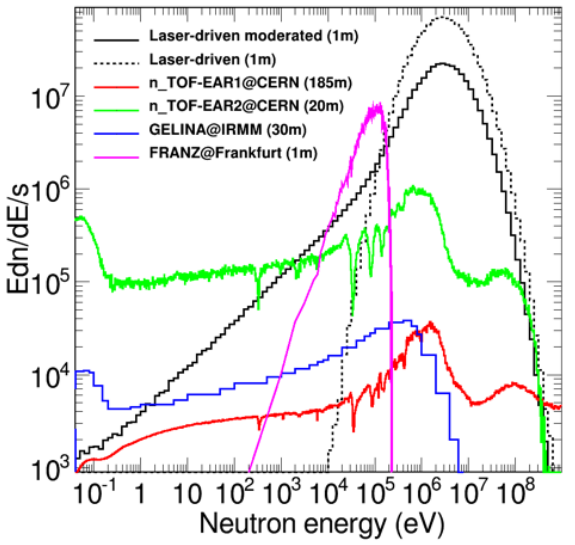
Figure 3. Neutron flux based in M. Roth, et al. results from 2013 experiments at TRIDENT PW Laser System [5]. Extracted from